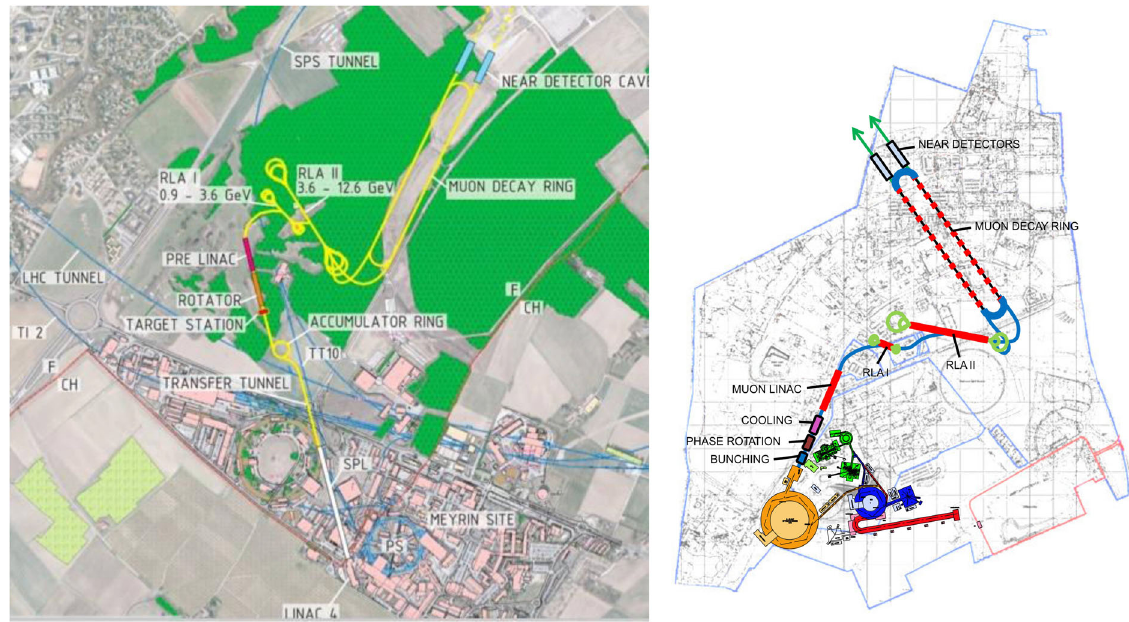
FIG. 14. Layout of the EURO ν baseline neutrino factory on the two sites considered by EURO ν . Left: Layout at CERN in which SPL servers accumulator and compressor rings and the muon-accelerator complex is laid out in the North Area. Right: Layout at RAL in which an upgrade of ISIS serves an RCS and the muon-accelerator complex is laid out on the Harwell